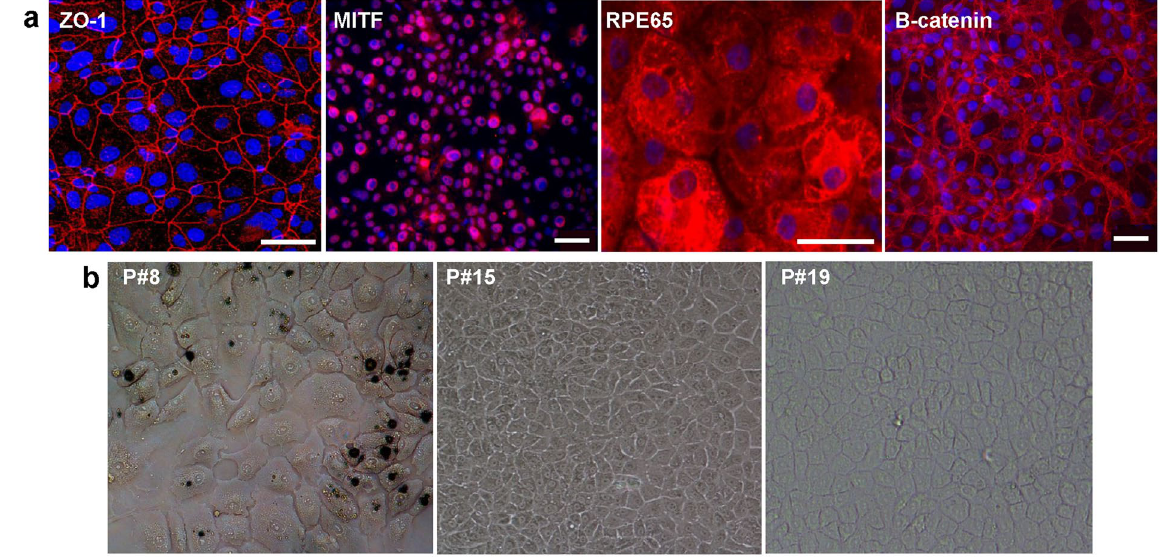
Figure 2. Primary human RPE cells. ( a ) Confocal images of immunostained primary human RPE cells using specific markers ZO-1 (Zona occludens-1), RPE65 (retinal pigment epithelium-specific 65 kDa protein), MITF (Microphtalmia-associated Transcription Factor), and β -catenin. ( b ) Light microscopy depicting primary human RPE cell morphology at different passages in culture. Scale bars, 50 μ